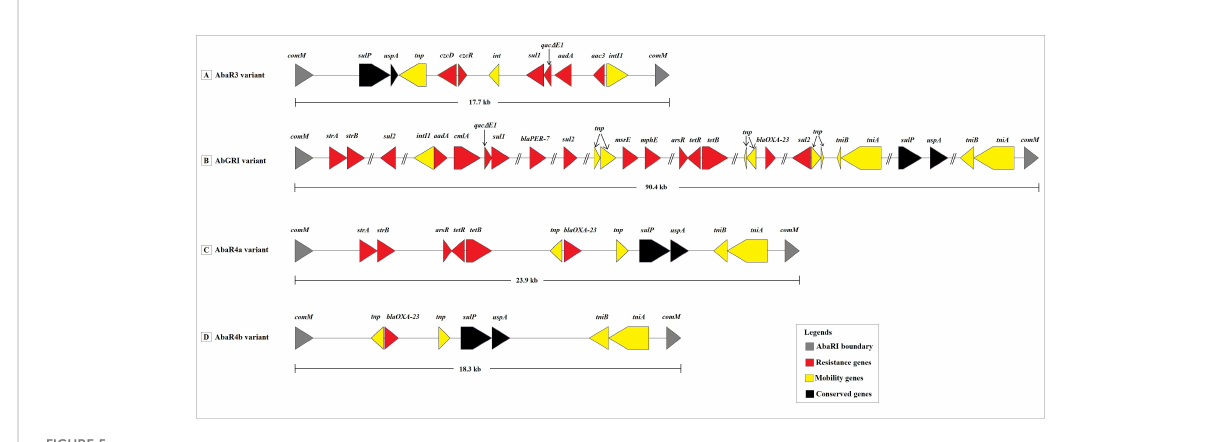
FIGURE 5 Schematic representation of four resistance island variants predicted in the study. (A) The AbaR3 variant predicted in AIIMS7 belonging to ST1. (B) The AbGRI variant predicted in VB23193 and VB35575 belonging to ST2. (C) The AbaR4a variant predicted in AIIMS5, VB33071, 6507, PM192696, PM1912235, VB473, VB723, VB958, VB1190, VB2107, VB2139, VB2181, VB2200, and VB7036 belonging to ST2. (D) The AbaR4b variant predicted in A. baumannii genomes belonging to ST10 (CIAT758, PM193665, PM194188), ST85 (VB82), ST575 (VB35435), ST25 (P7774), ST622 (VB16141, KSK6, KSK7, KSK10, KSK18, KSK19, KSK20), and ST1512 (VB35179). Legends: comM , ATPase; sulP , sulfate permease; uspA , universal stress protein A; tnp , Il-IS2 transposase; czcD , cobalt/zinc/cadmium resistance protein; czcR , Cd(II)/Pb(II)-responsive transcriptional regulator; int , prophage integrase; sul1 and sul2 , sulfonamide resistance protein; qac D E1 , quaternary ammonium compounds ef fl ux transporter; aadA , aminoglycoside 3 ’’ -nucleotidyltransferase; aac3 , aminoglycoside N(3)-acetyltransferase; intI1 , integron integrase; tniB , NTP binding protein; tniA , transposase; strA , aminoglycoside 3 ’’ -phosphotransferase; strB , aminoglycoside 6-phosphotransferase; arsR , transcriptional regulator; tetR , tetracycline resistance regulatory protein; tetB , tetracycline resistance ef fl ux protein; cmlA , chloramphenicol ef fl ux pump; blaPER-7 , class A b -lactamase; msrE , erythromycin resistance; mphE , macrolide 2 ’ phosphotransferase; blaOXA-23 , class D b